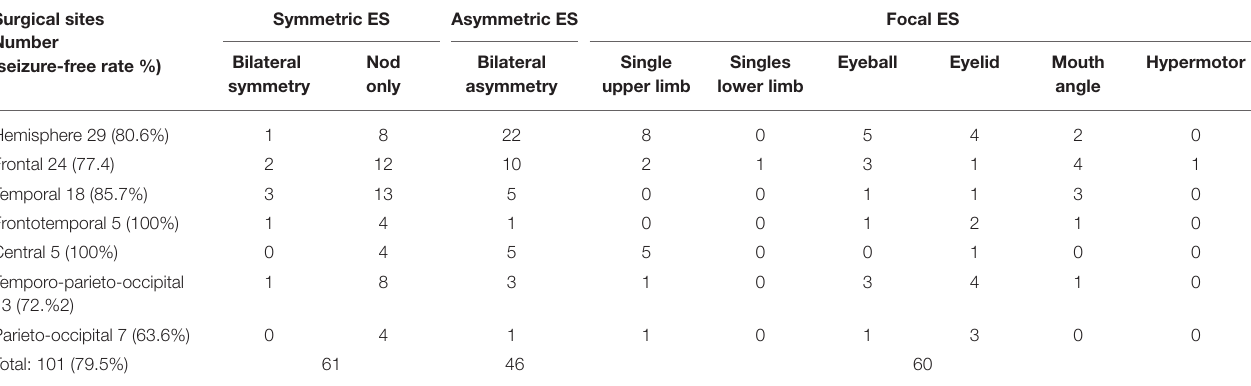
Symmetric ES Asymmetric ES Focal ES Bilateral Nod symmetry only